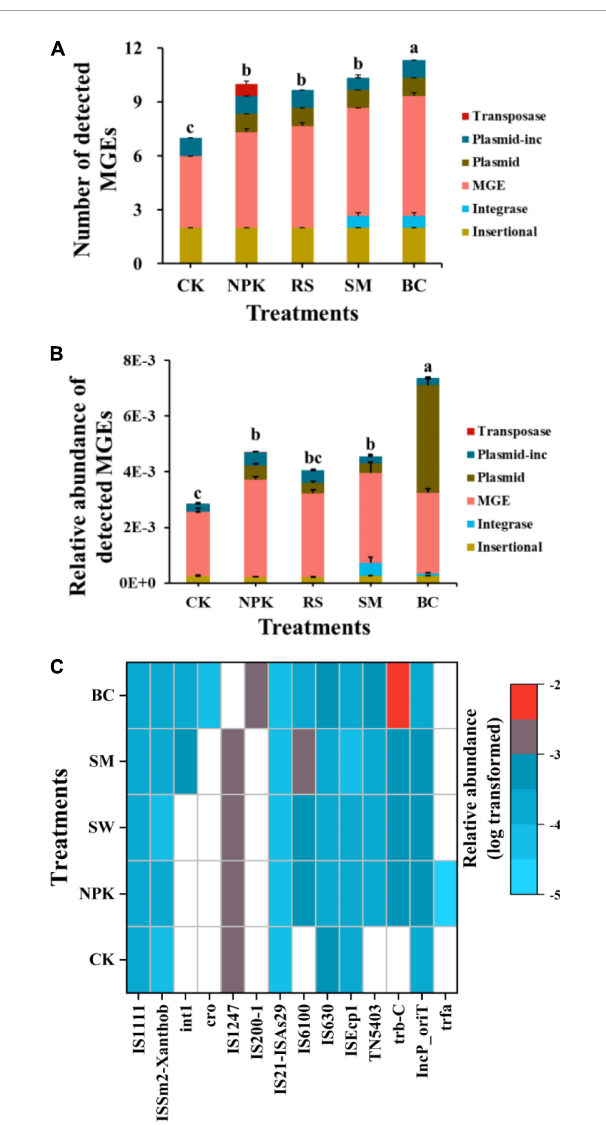
FIGURE3 Detection number (A) and relative abundance (B) of MGEs categorized by MGE type detected in different management practices and the relative abundance of individual MGEs detected in soil samples (C) .